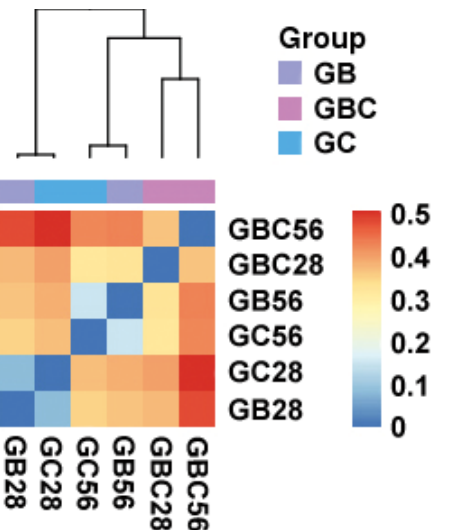
SDFig. 6. Beta diversity analysis based on weighted UniFrac dis- tances. Treatment (GC: control; GB: bacteria; GBC: bacteria−